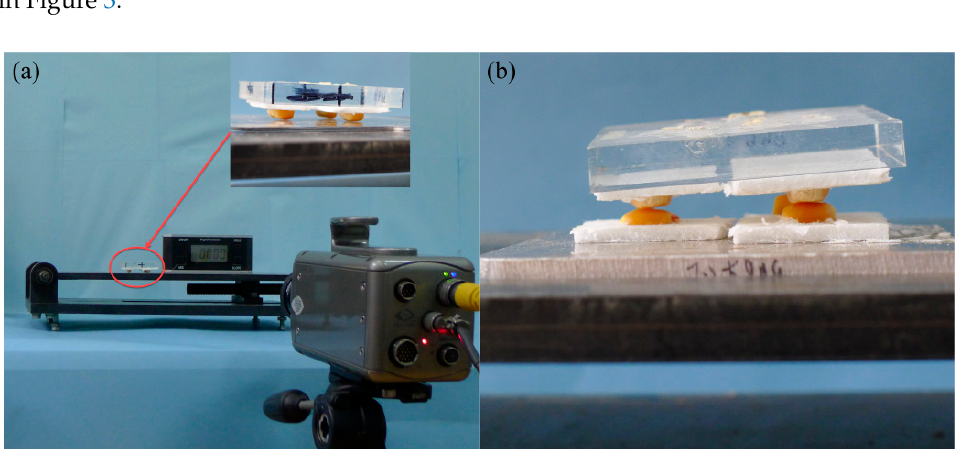
Figure 3. Experimental setup for coefficients of static friction ( a ) between seed particles and ( b ) between particles and wall measurement.